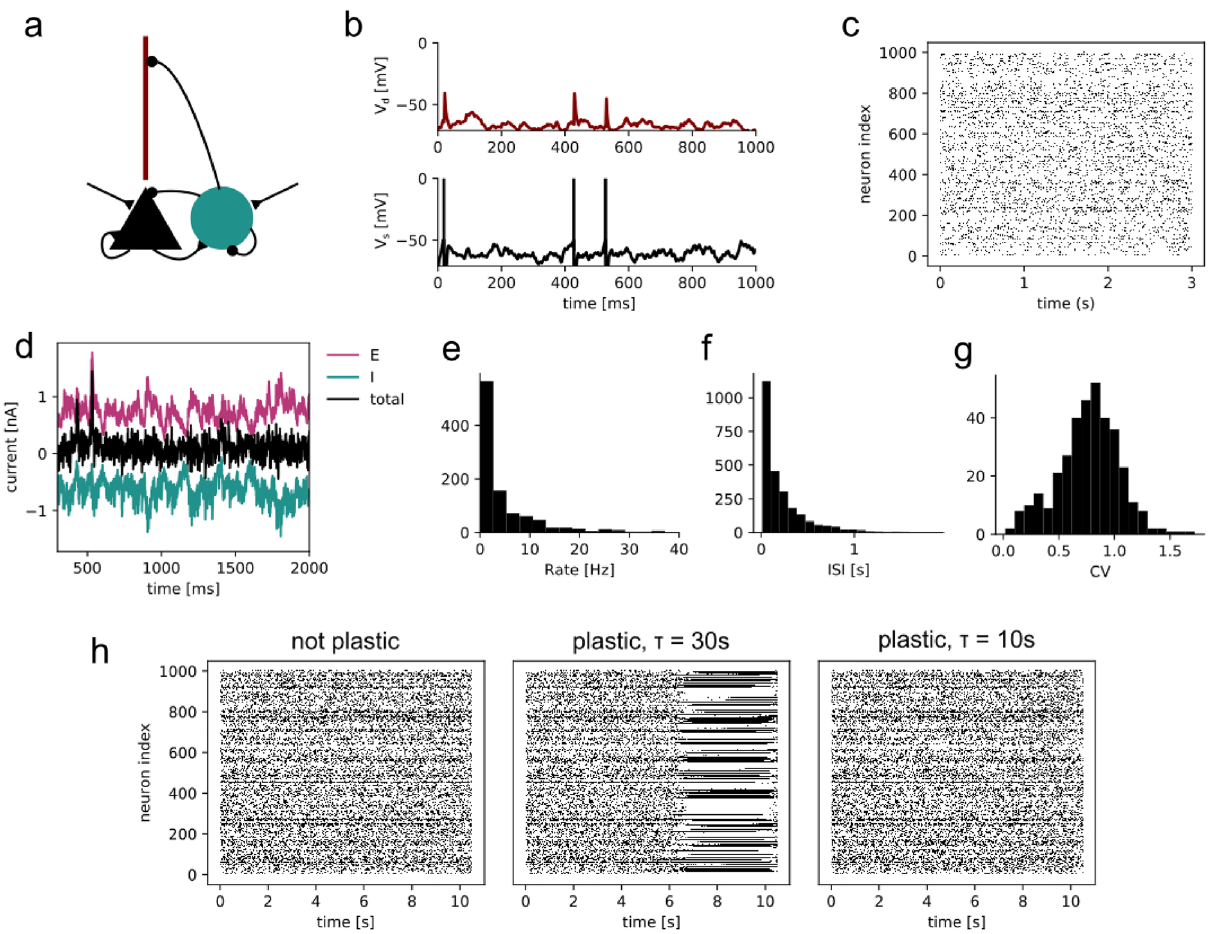
Figure 1. Balanced spiking neural network with 2-compartment pyramidal cells. ( a ) The network consisted of 1000 recurrently connected 2-compartment pyramidal cells (triangle and stick), and 250 recurrently connected inhibitory cells (circle). Both the excitatory and the inhibitory population receive external Poisson inputs (black arrows). ( b ) Somatic (black) and dendritic (red) voltage traces from one example pyramidal cell. ( c ) Raster plot of excitatory cell activity in the network. ( d ) Example currents from one example pyramidal cell. It receives large E (magenta) and I (cyan) currents which cancel on average (black). ( e ) Distribution of excitatory firing rates. ( f ) Distribution of excitatory interspike intervals. ( g ) Distribution of coefficient of variation (CV) of the interspike intervals. e-g indicate that the network is in a balanced state. ( h ) Raster plots of excitatory network activity in a network without plasticity (left), with plasticity and a homeostatic time constant τ = 30s , and with plasticity and a homeostatic time constant τ = 10s